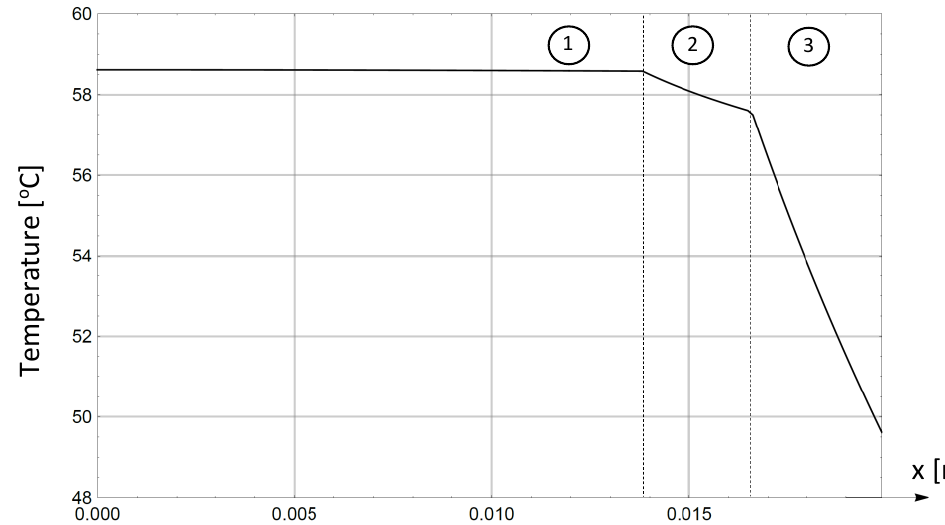
Figure 5. Temperature change in the test model on semi-axis y = 0 (for I cr = 553.51 A ).